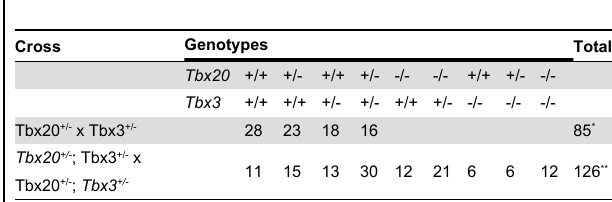
Table 1. Number of offspring of each genotype from intercrosses of Tbx20 and Tbx3 heterozygotes, recovered at weaning, and from crosses of mice double heterozygotes for both genes, recovered at midgestation.